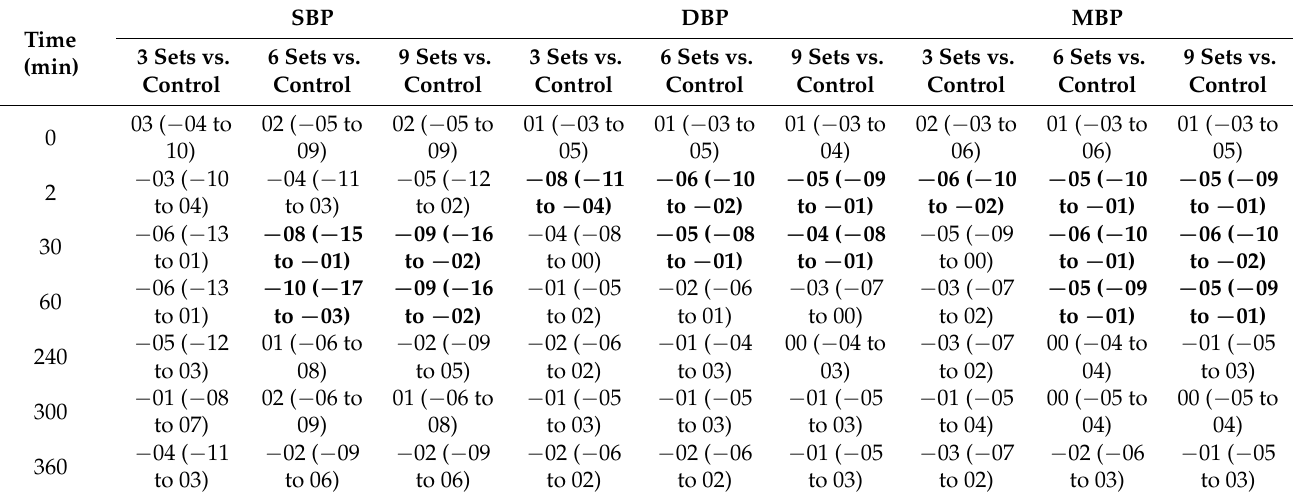
Table 4. Differences in least square means (95% CI) of SBP, DBP, and MBP of control vs. other